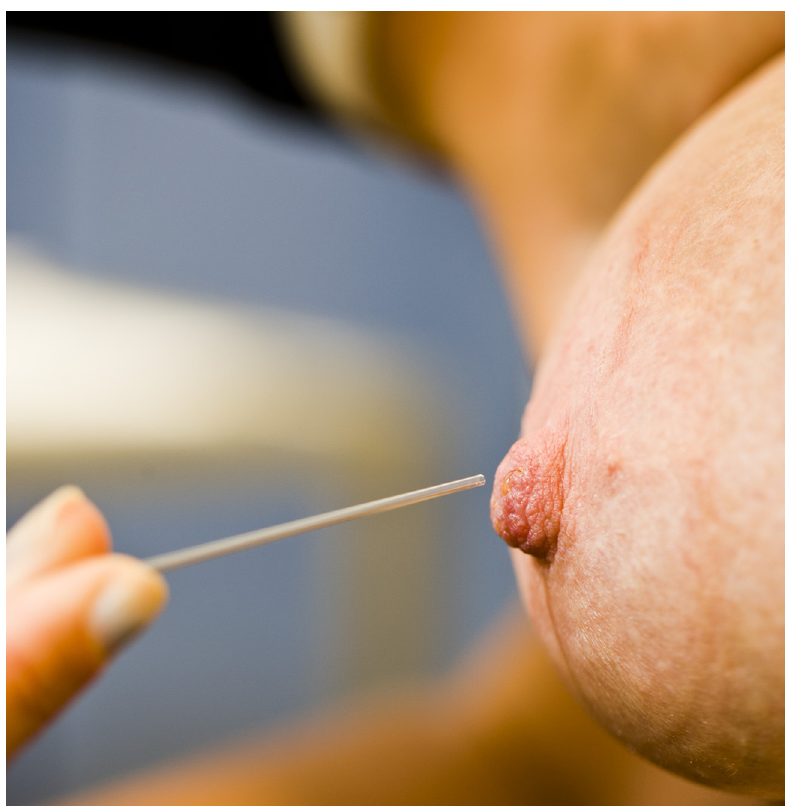
Fig 1. Nipple fluid collected by a capillary tube after nipple fluid aspiration